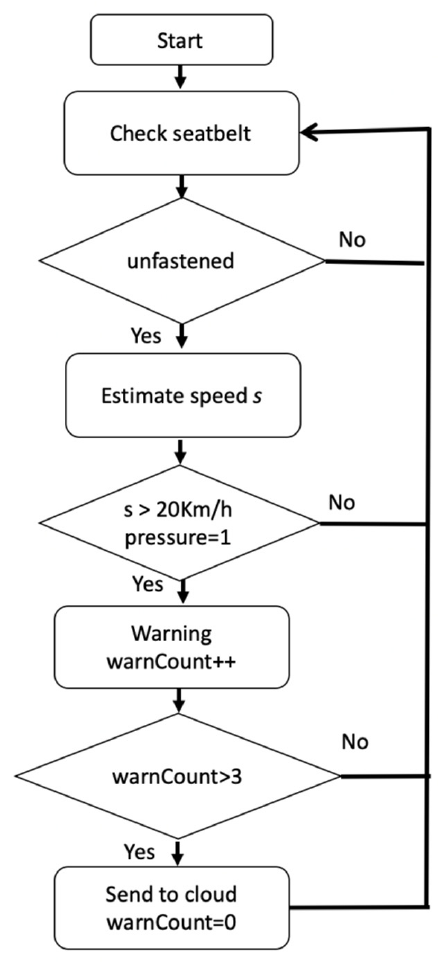
Figure 4. The flow chart of the seatbelt checking algorithm in the fog layer. The algorithm checks whether the seatbelt is fastened or not when the vehicle is moving and the seat is occupied. The algorithm warns the driver three times before sending the fine request to the cloud if the seatbelt is unfastened.